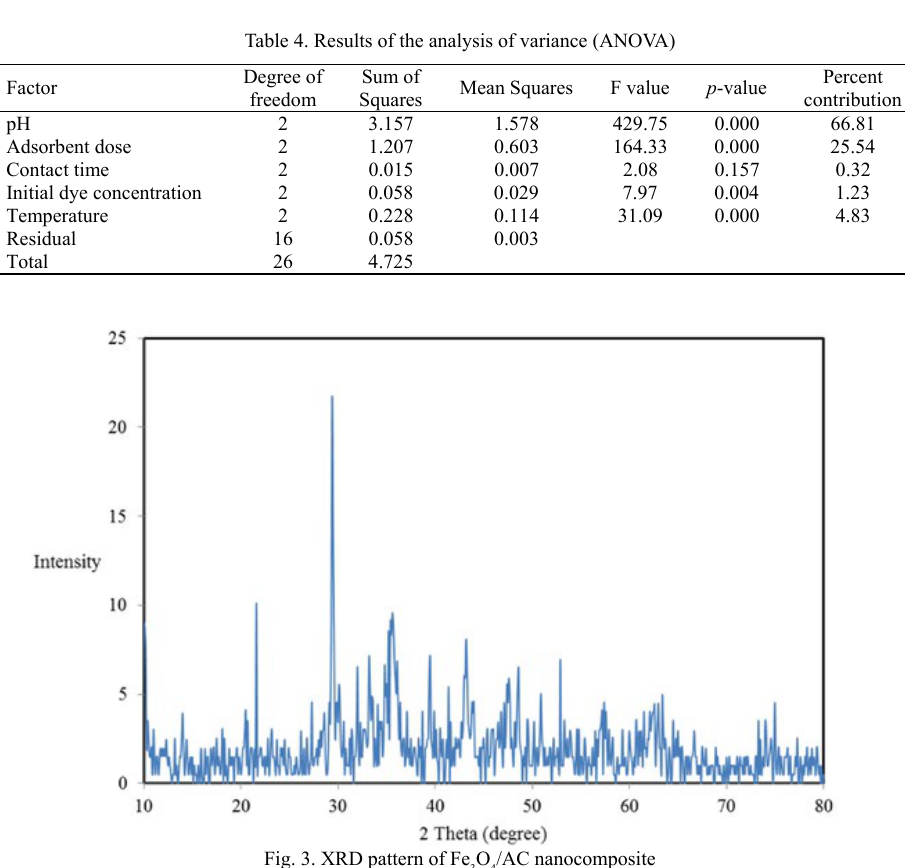
O /AC nanocomposite 3 4